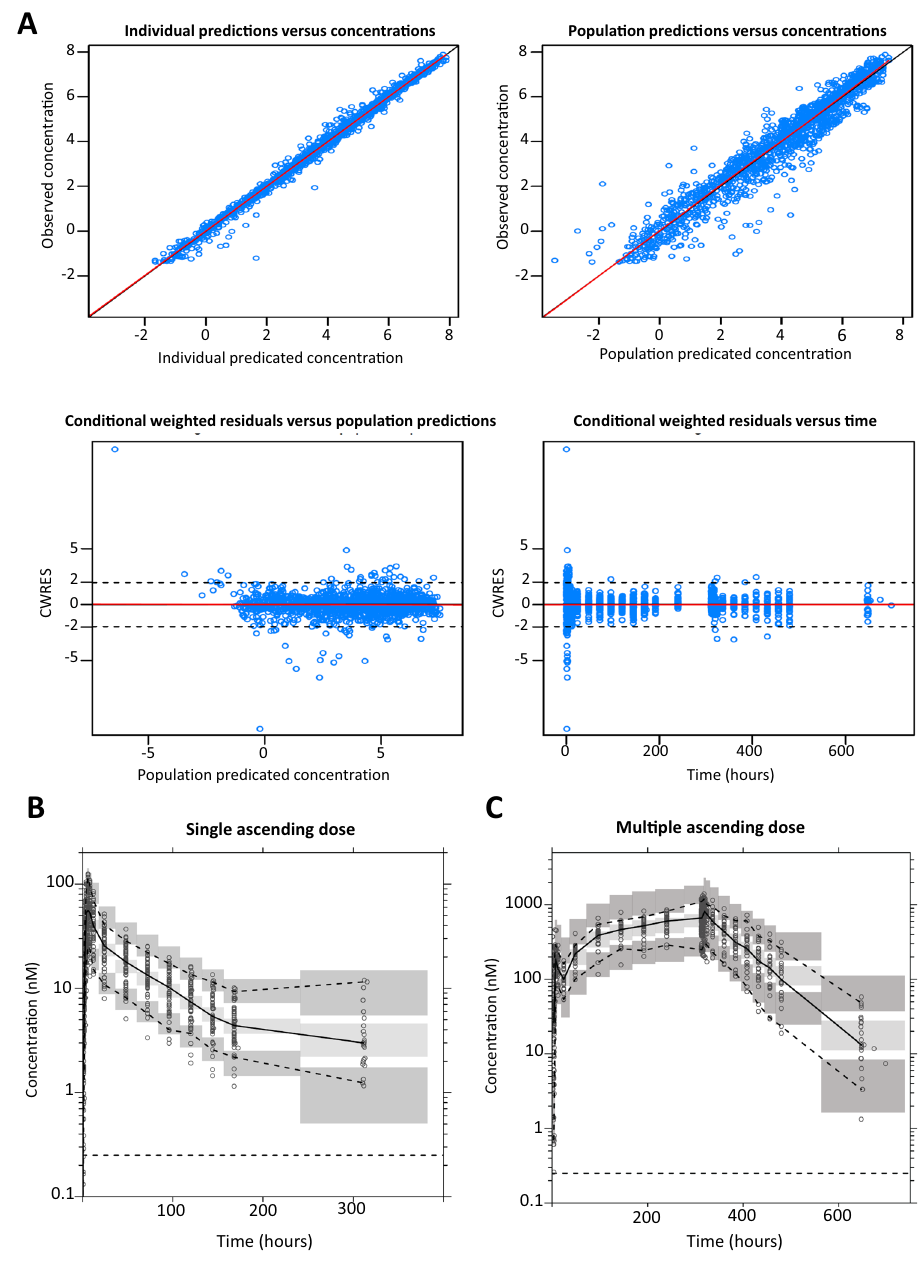
Fig. 6 | TD-6450 modeling based on phase I results. Goodness-of- fi t ( A ) of the fi nal pharmacokinetic model. Simulation-based ( n =2000 independent simula- tions) diagnostics (pvcVPC), displaying the predictive performance of the fi nal PK